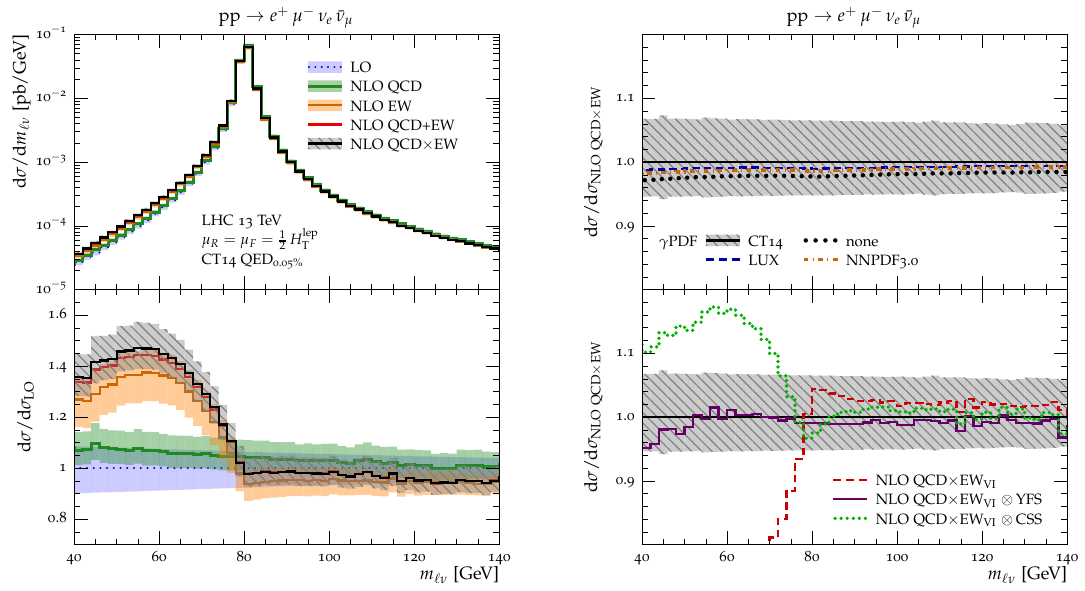
Figure 13 . Distribution in the invariant mass of the matching lepton-neutrino pair, m pp e + (cid:22) (cid:0) (cid:23) e (cid:22) (cid:23) (cid:22) at 13 TeV. Details as in (cid:12)gure 9. !